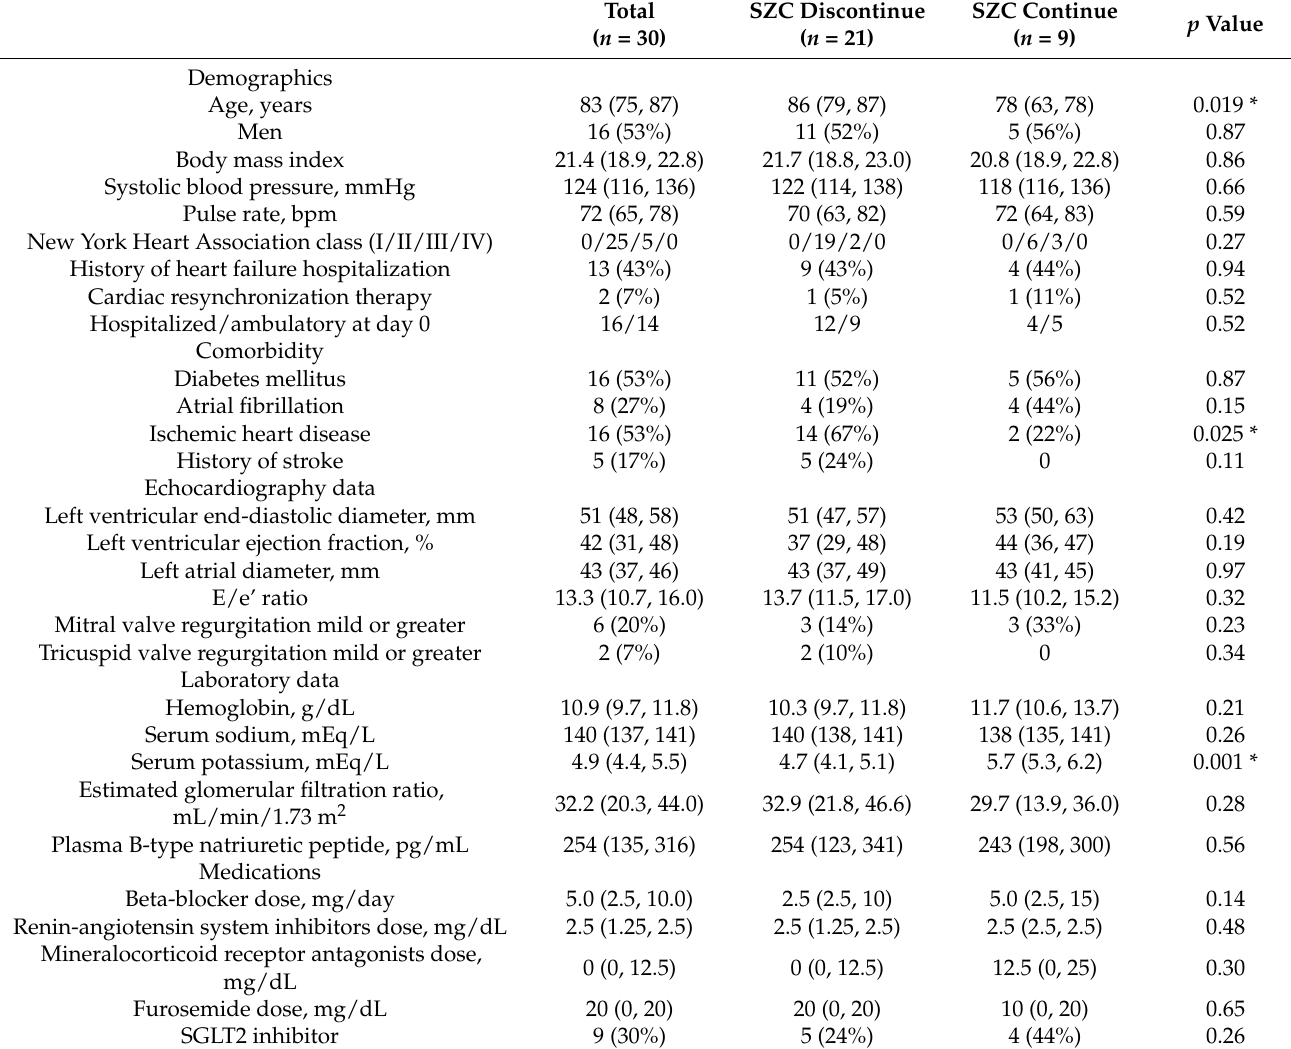
Table 1. Baseline